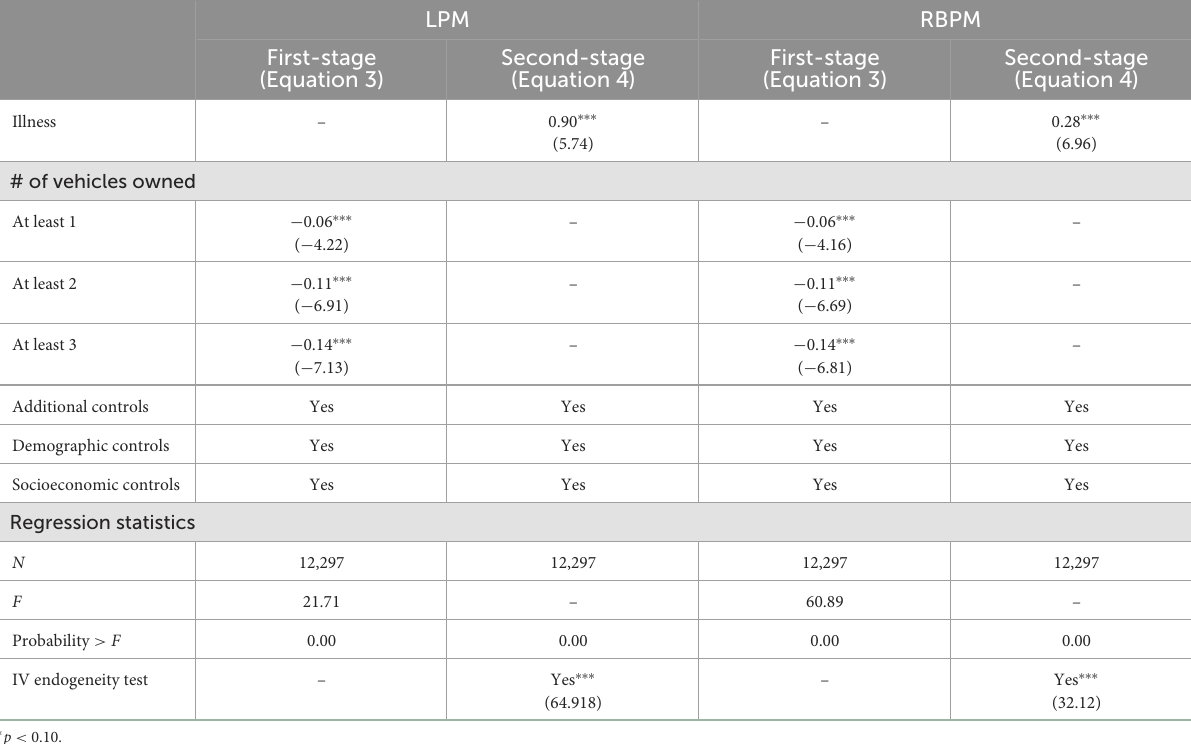
TABLE 3 Instrumental variable (IV) specifications. LPM